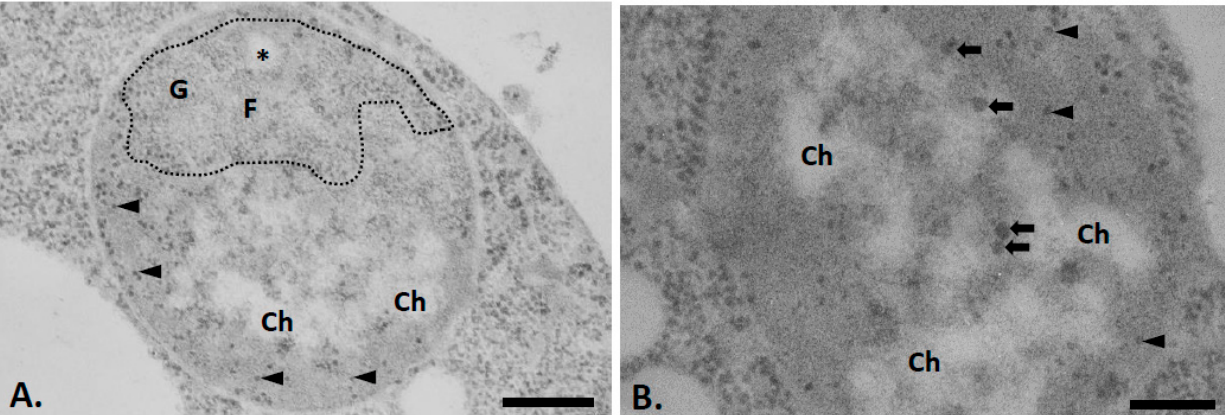
Figure 3. Nuclei of exponentially growing yeast cells subjected to hyperosmotic shock as revealed after the application of the cytochemical method of acetylation combined with the technique of regressive EDTA staining to visualize RNP-containing structures. Dense masses (Ch) present in nucleoplasmic region and in the heterogenous areas of the nucleolus (asterisks) are “bleached” indicating they consisted mostly of DNA. The fibrillar strands (F) and granular masses (G) of the nucleoli remain contrasted as well as the small (arrowheads) and large extranucleolar granules (thick arrows). The latter are always associated with dense masses. Bars = 0.5 ( A ) or 0.25 μ m ( B ).